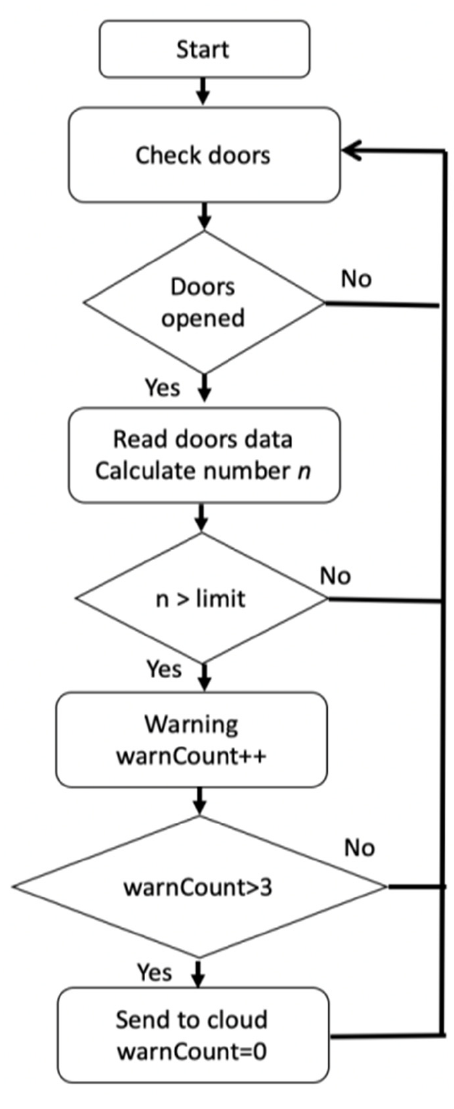
Figure 2. The flow chart of the passenger counting algorithm in the fog layer. The algorithm counts the number of passengers when the doors are opened, and warns the driver three times if the number exceeds the permitted value, before sending a fine request to the cloud.